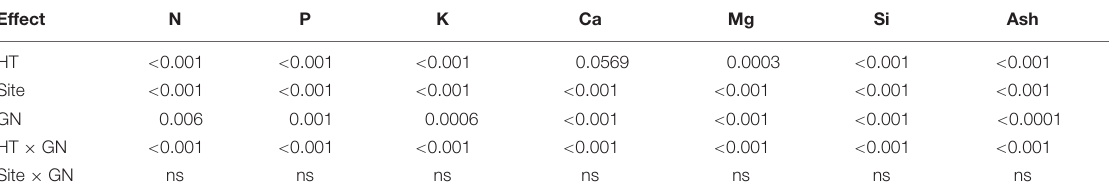
TABLE 3 | P -values for various quality parameters.